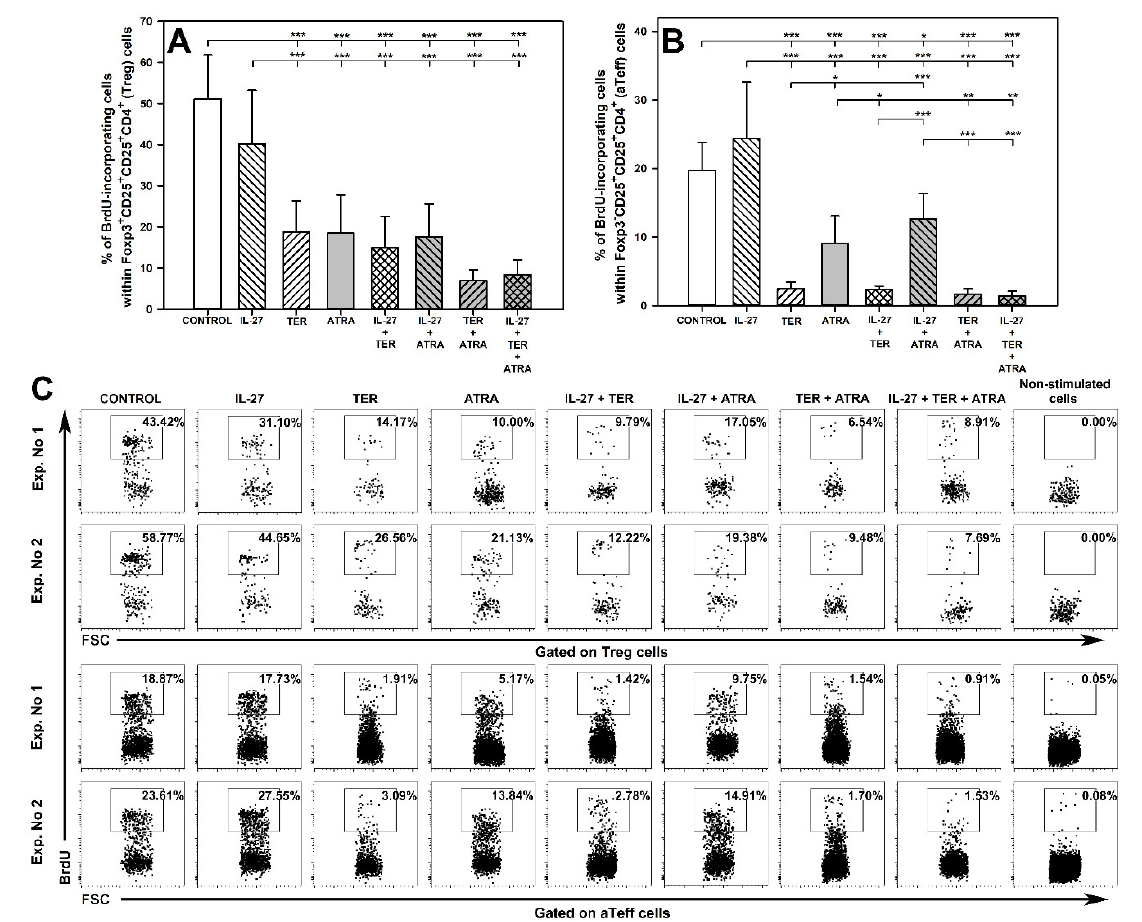
Figure 2. Effect of IL-27, teriflunomide (TER), all-trans-retinoic acid (ATRA), and their combinations on the proliferation of Foxp3 + CD25 + CD4 + and Foxp3 − CD25 + CD4 + T cells, i.e., regulatory (Treg) and activated effector (aTeff) T cells, respectively. The relative count of 5-bromo-2-deoxyuridine(BrdU)- incorporating cells within Foxp3 + CD25 + CD4 + ( A ) and Foxp3 − CD25 + CD4 + ( B ) T cell subsets was determined in cell cultures incubated in the absence (CONTROL) and presence of IL-27 (100 ng/mL), TER (10 −4 M), and ATRA (10 −6 M) for 72 h including concomitant stimulation with IL-2, anti-CD3, and anti-CD28 and re-stimulation with PMA and ionomycin for the last 5 h before harvest. The cells were exposed to BrdU during the last 12 h. Results are expressed as the mean (± S.D.) of two inde- pendent experiments with four mice per experiment (overall n = 8, * p < 0.05, ** p < 0.01, *** p < 0.001). Examples of dot plot cytograms showing the distribution of BrdU-incorporating cells within Foxp3 + CD25 + CD4 + ( C , upper panel) and Foxp3 − CD25 + CD4 + ( C , lower panel) T cell subsets.